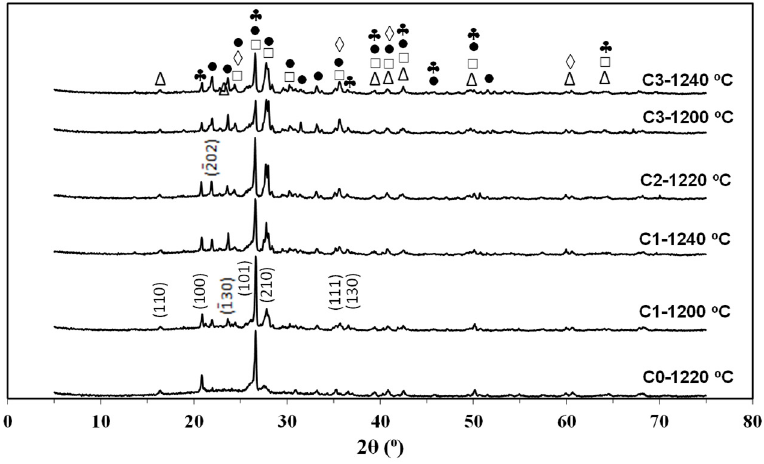
Figure 9. XRD patterns of studied compositions: ◊ Hematite; ♣ Quartz; ∆ Mullite; □ Augite; • Anorthite.